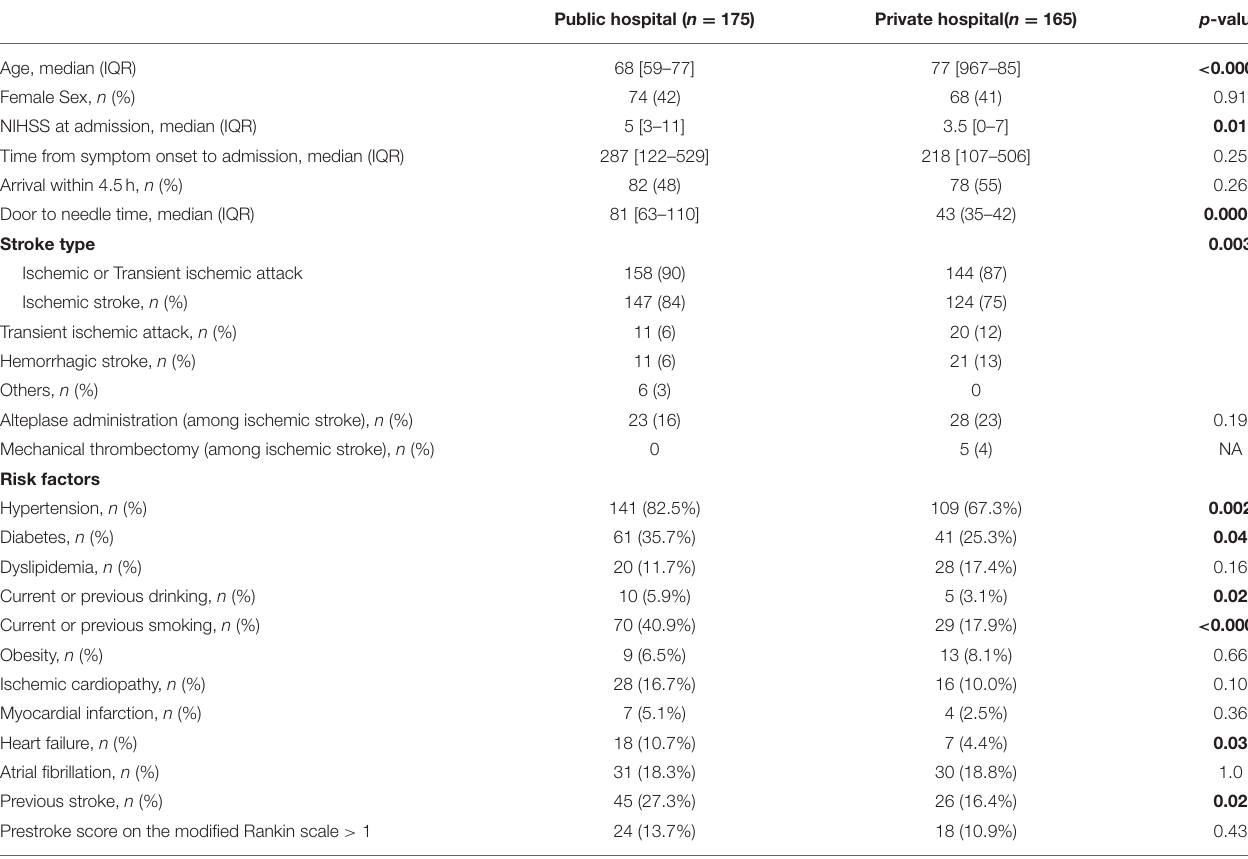
TABLE 1 | Baseline